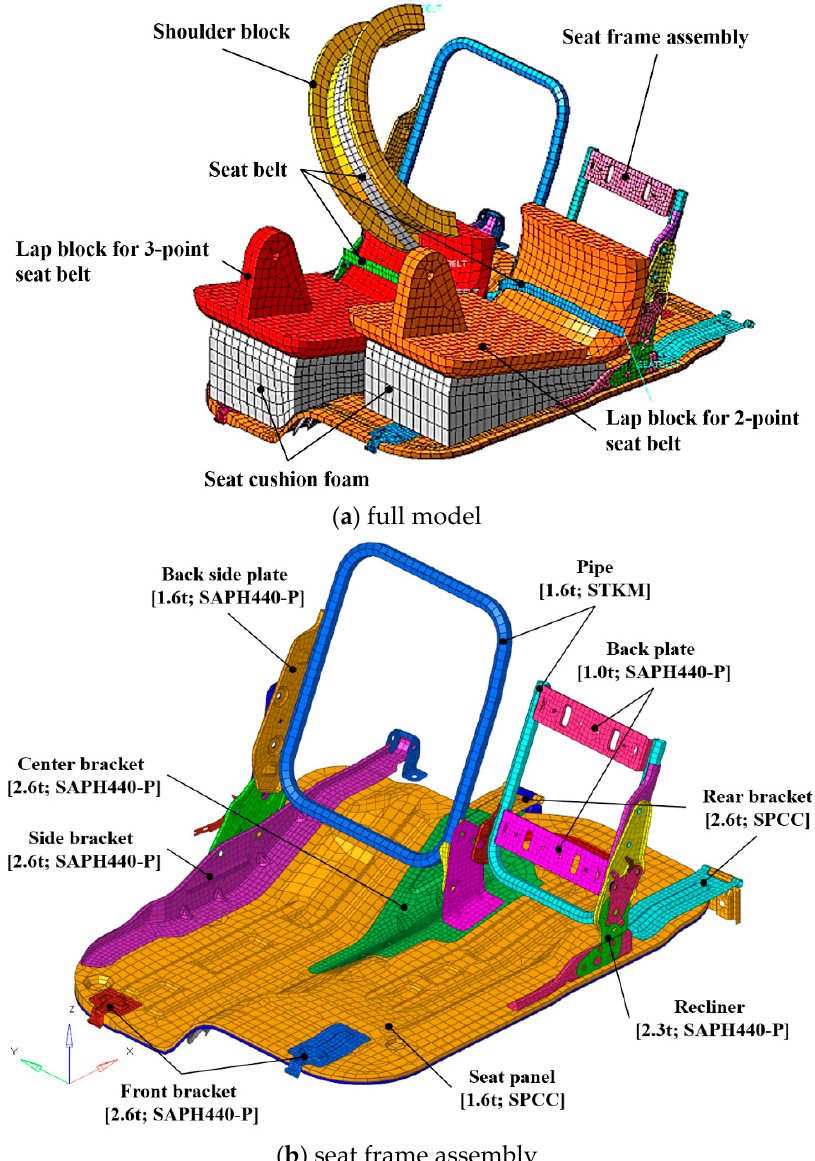
Figure 4. FEA model for seat belt anchorage simulation.